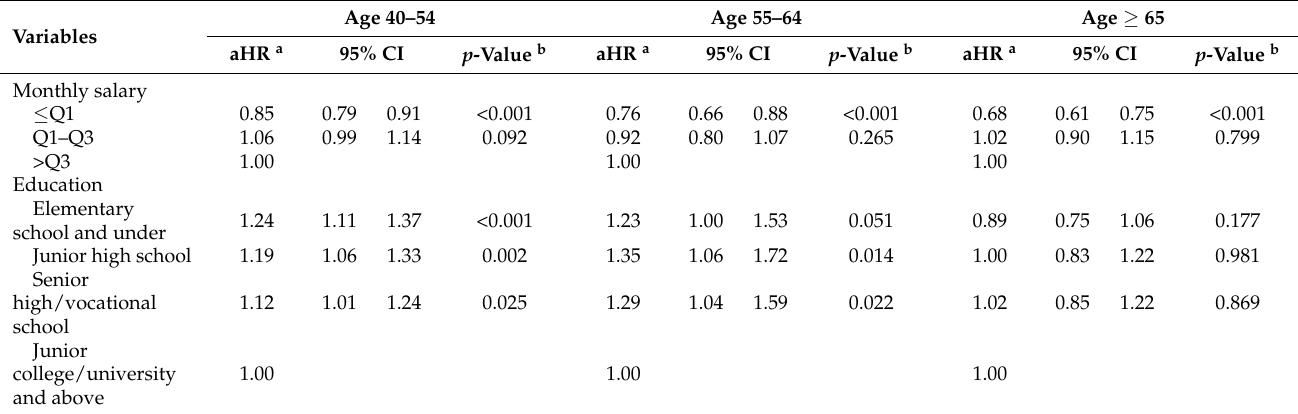
Table 3. Incidence risk of colorectal cancer in study participants stratified by age.